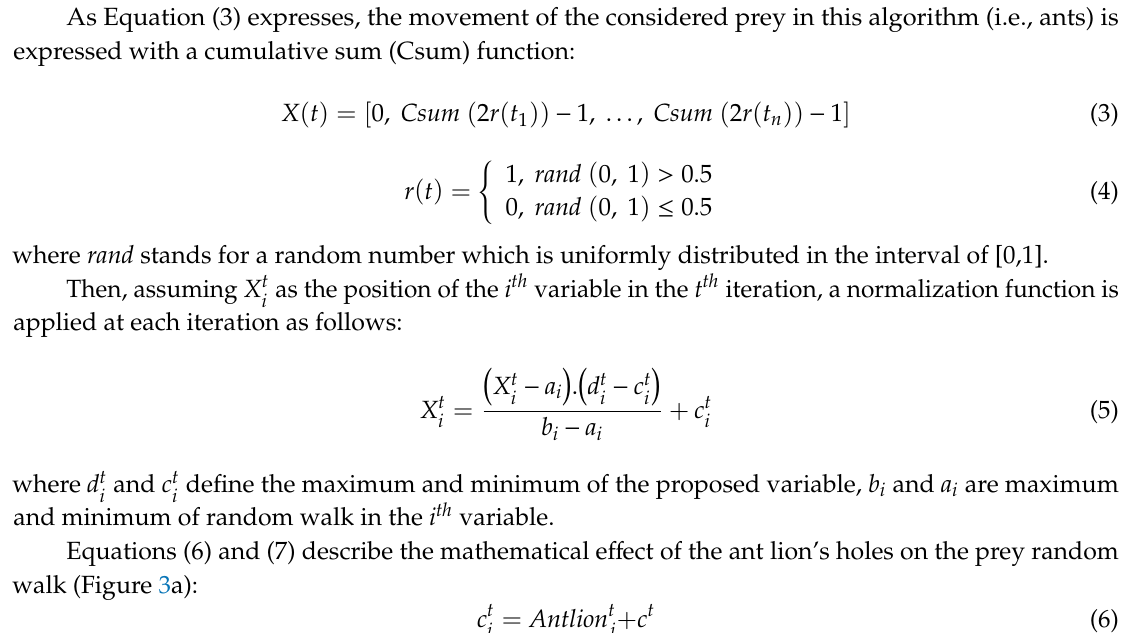
Figure 2. The flowchart of the ALO algorithm.